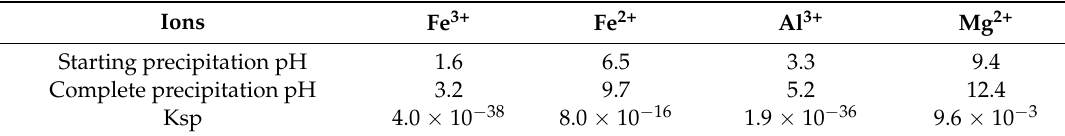
Table 4. Metal hydroxides precipitation pH value and solubility product constant Ksp